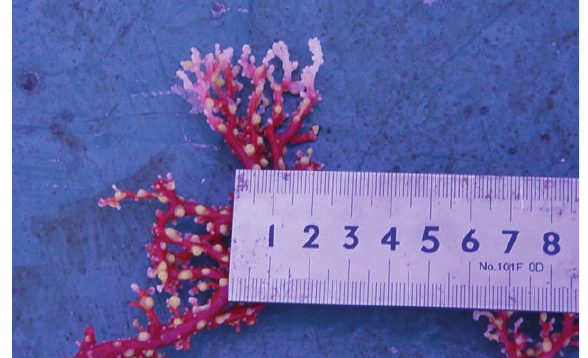
Figure 13: A commensal zoanthid (yellow in color), Corallizoan- thus tsukaharai associated on the surface of Paracorallium japon- icum ; OCA-Cn20060109-042. The scale divisions are 1.0